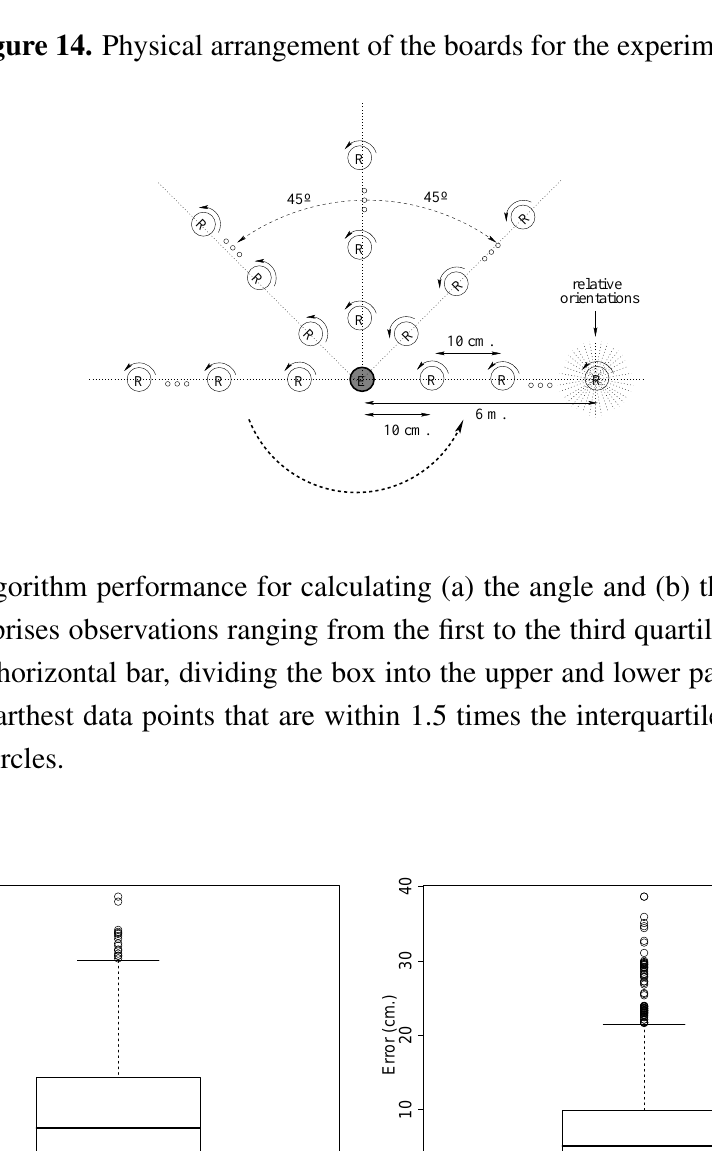
Figure 14. Physical arrangement of the boards for the experiments.